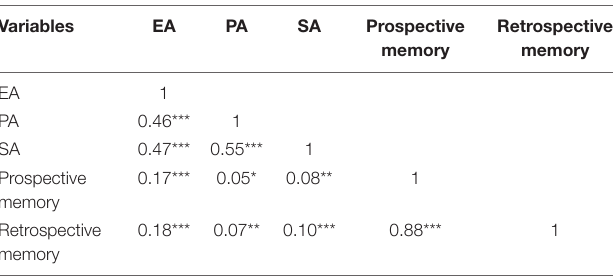
TABLE 1 | The Pearson correlation analysis of childhood abuse and prospective memory and retrospective